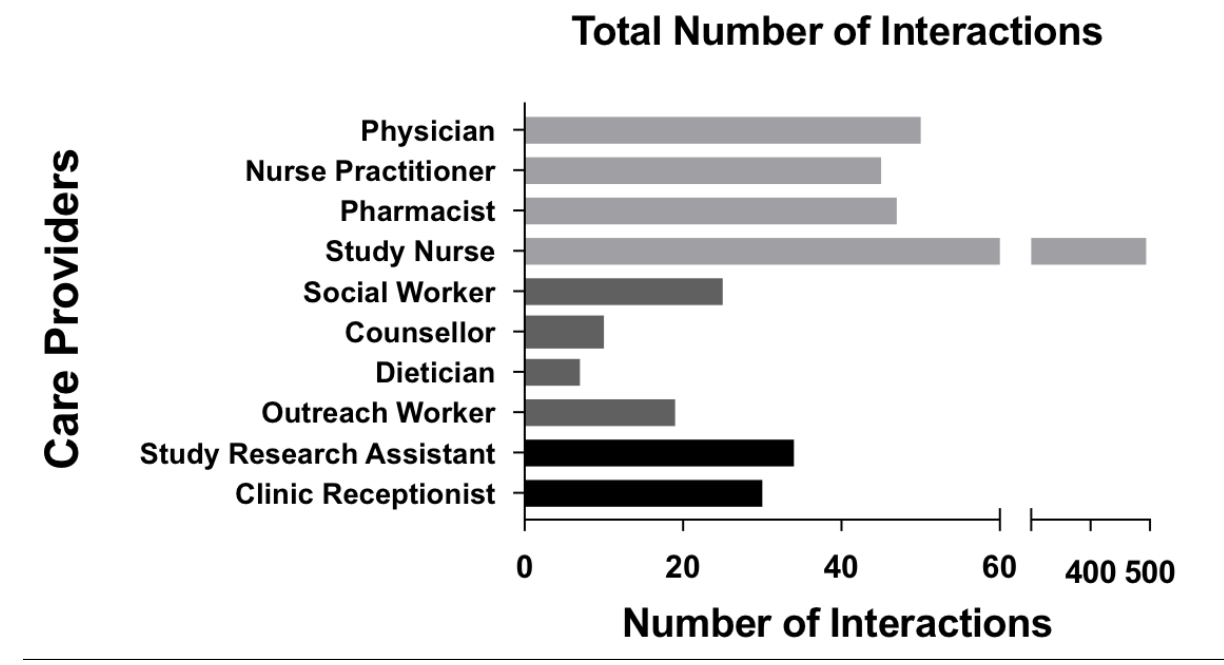
Figure 2. Total number of interactions with participants per health care provider over study year.